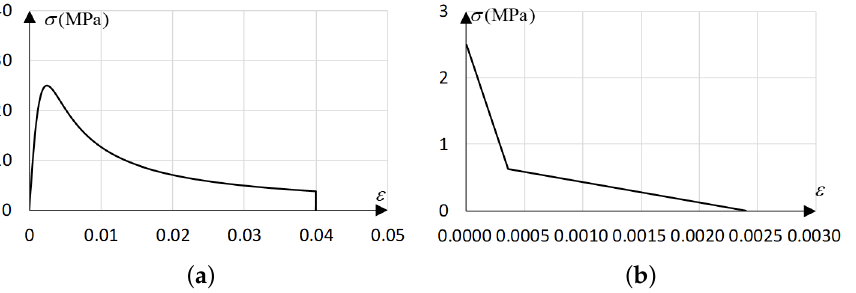
Figure 8. Uniaxial stress-strain relationship of concrete. ( a ) Compressive stress-strain relations. ( b ) Tensile stress-strain